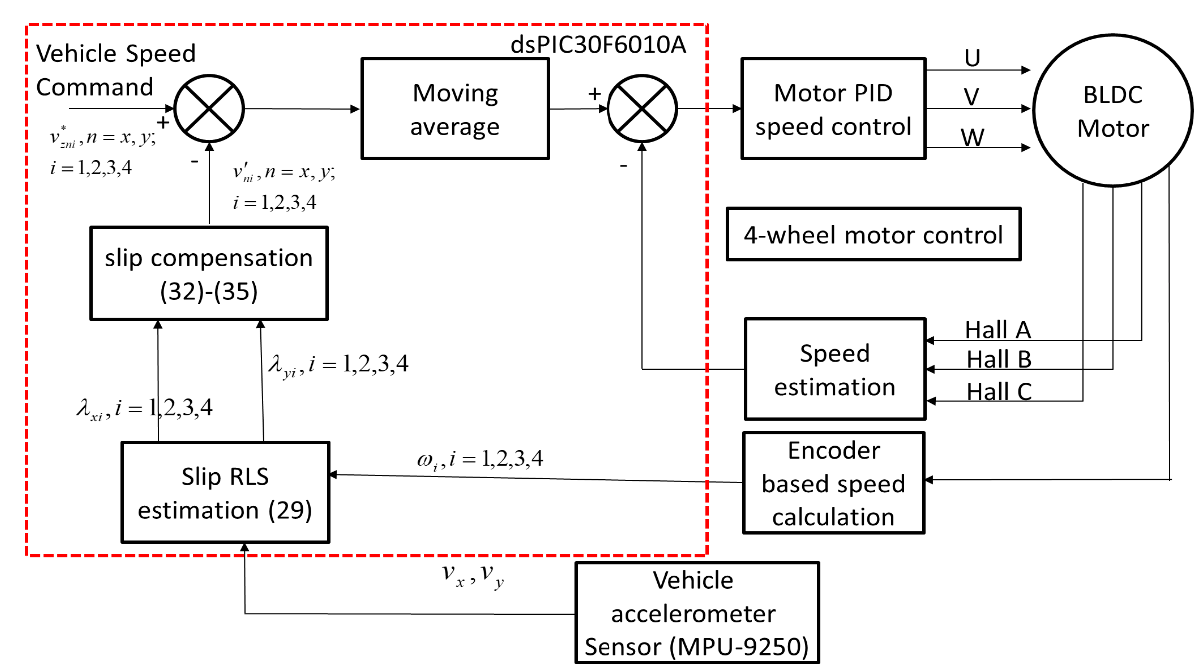
Figure 3. The block diagram of slip error compensation control for the omnidirectional Mecanum-wheeled automated guided vehicle driven by BLDC motors.